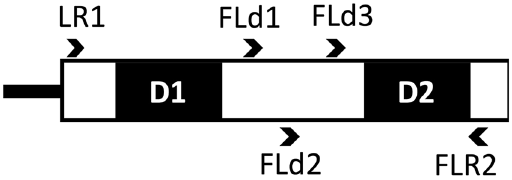
Figure 1. Relative locations and directions of PCR primers for amplification of the large subunit ribosomal RNA gene. Three forward primers, FLd1, FLd2 and FLd3, were designed in the region between the divergent domains 1 (D1) and 2